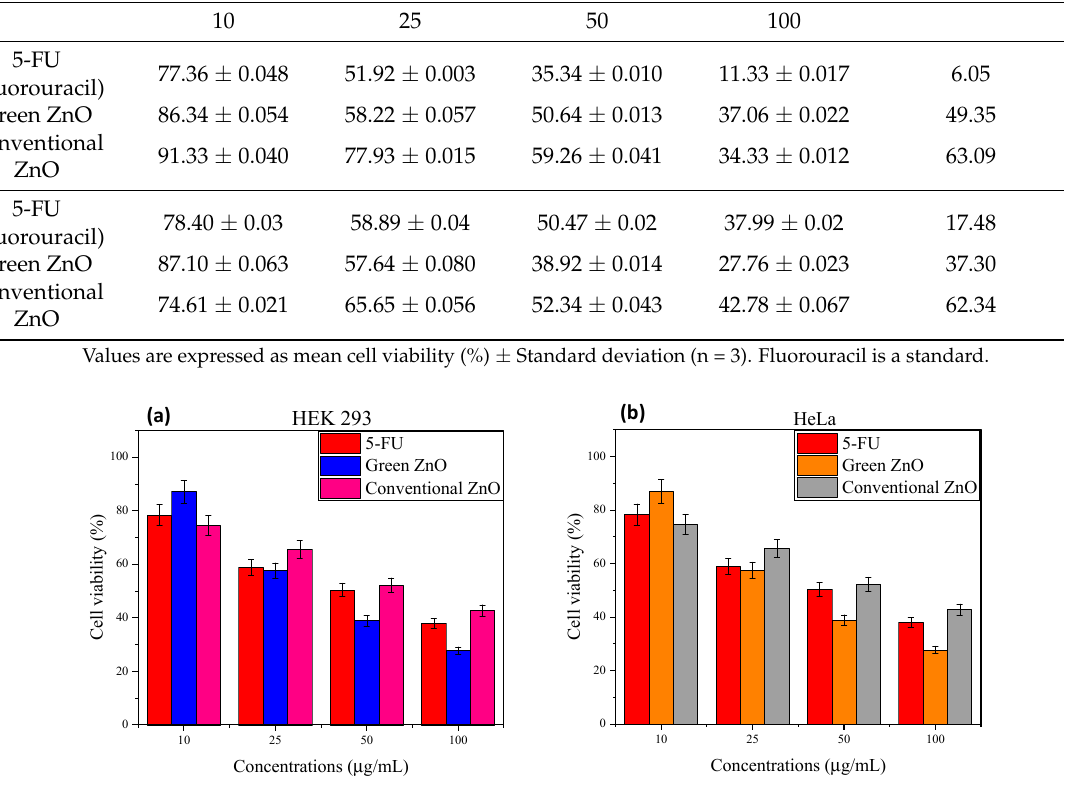
Figure 7. The percentage cell viability of: ( a ) HEK 293, and ( b ) HeLa cells treated with various concentrations of green and conventional ZnO-NPs.